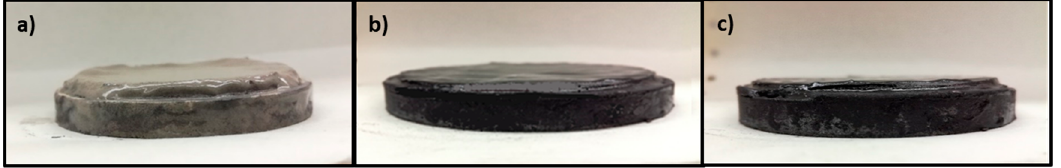
Figure 12. The resulting filter cakes: ( a ) 100 wt.% barite (2.59 mm), ( b ) 25wt.% ilmenite (2.56 mm), and ( c ) 50 wt.% ilmenite (2.51 mm). Table 5. Summary for HPHT filtration test results .